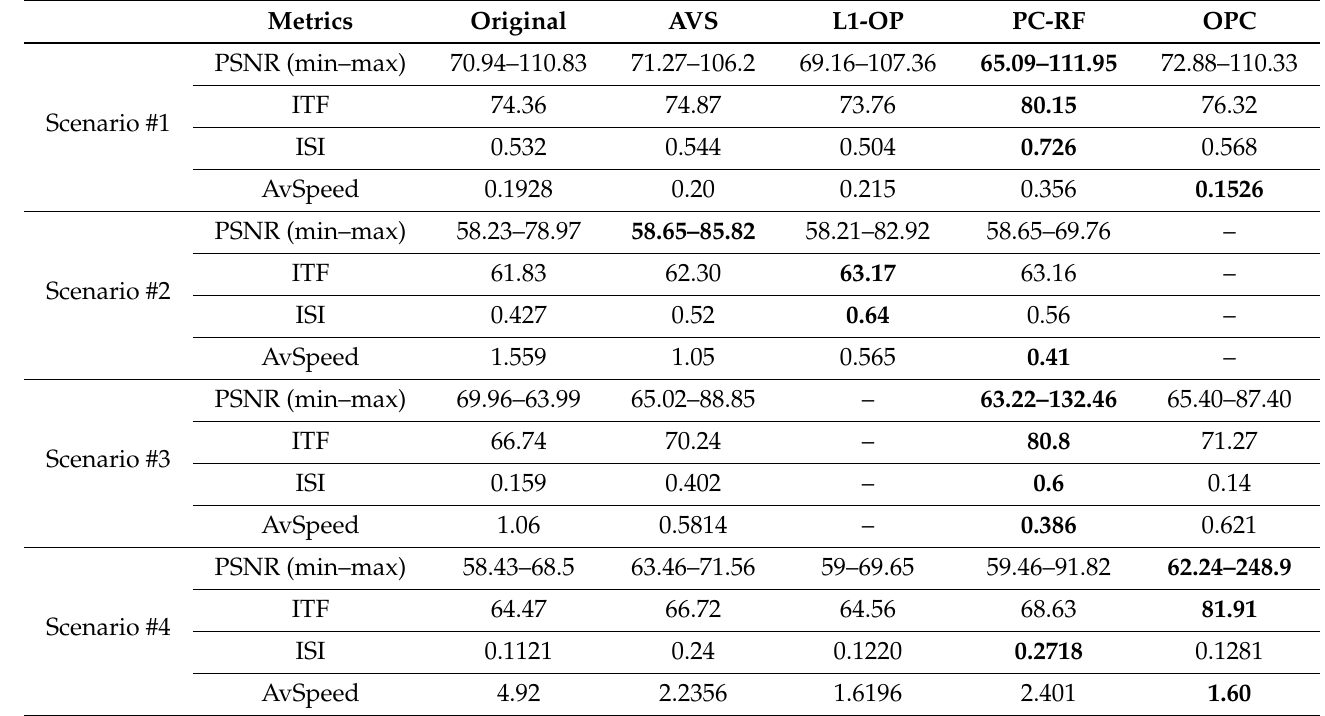
PSNR: higher value indicates higher system accuracy. ITF: the higher shows smoother camera motions (perfect stabilization results infinity value. SSIM: higher value shows better performance. ISI: higher value shows higher similarity between frames. AvSpeed: the lower value shows more perceptual